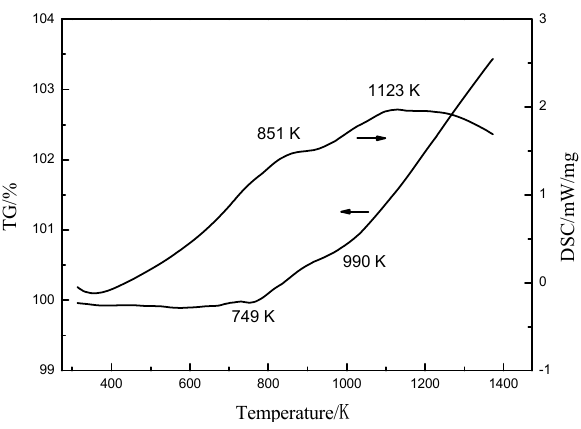
Figure 1. TG/DSC curves of titania slag.